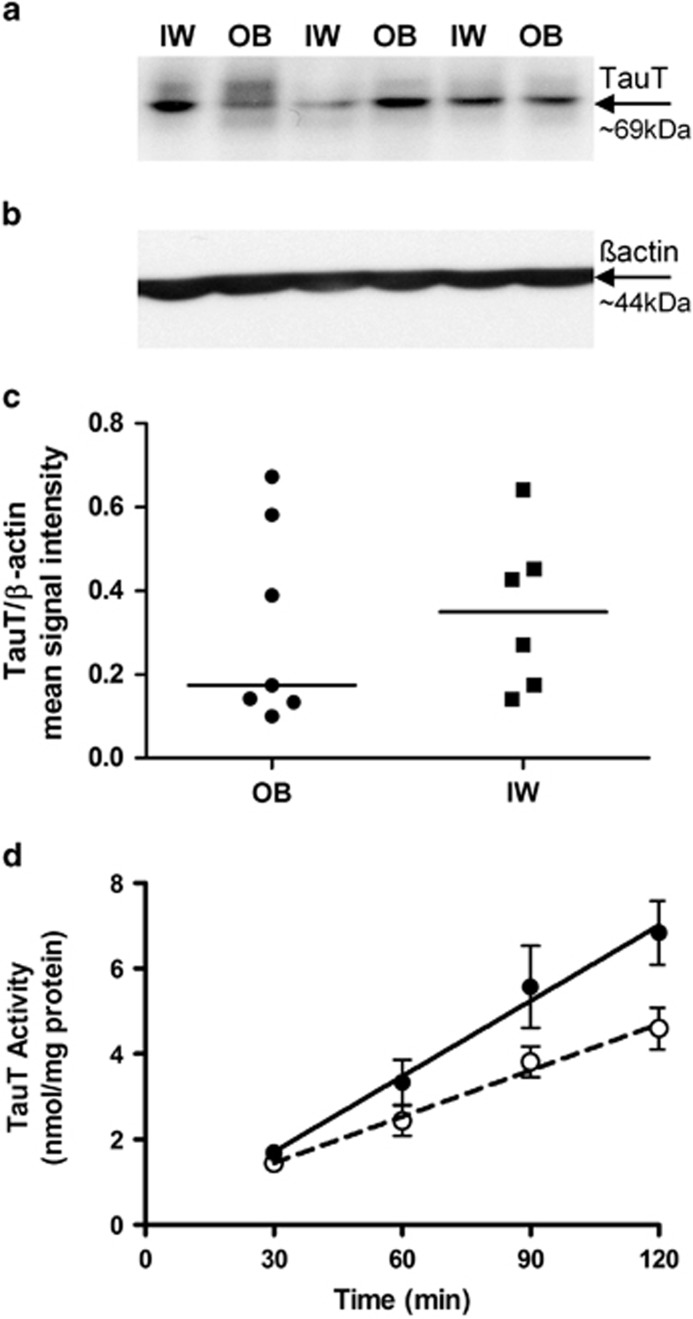
Representative western blots of placental membrane-enriched fractions from three women of ideal weight (IW) and three women who were obese class III (BMI⩾40 kg m−2: obese, OB) subjects probed for TauT and β-actin. Protein loading was 50 μg per lane. (a) After probing for TauT, an immunoreactive species was detected at ~69 kDa in all samples. (b) After re-probing membranes for β-actin, an immunoreactive species was detected at ~44 kDa. (c) Scatter plots display densitometric analysis of TauT signal intensity after normalizing to β-actin (line at median). There was no significant difference in TauT protein expression between IW (n=6) and OB (n=7) groups (Mann–Whitney U-test: P>0.05). (d) Placental TauT activity, in the same placentas in which TauT expression was determined, was significantly lower in class III obese women (n=7; (○)) than women of IW (n=6; (○)) (mean±s.e.; *P<0.05, least squares linear regression).